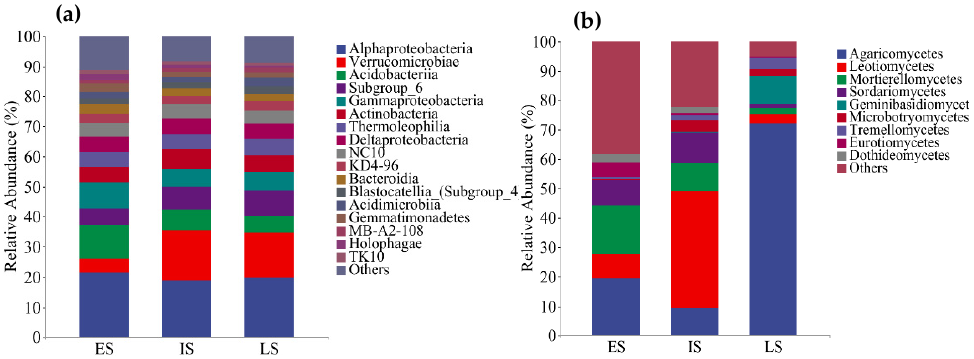
Figure 4. Relative abundance of soil bacteria ( a ) and fungi ( b ) class-level composition with three successional stages of broad-leaved Korean pine forest in Lesser Hinggan Mountains. ES: Early-stage; IS: Intermediate-stage; LS: Late-stage.